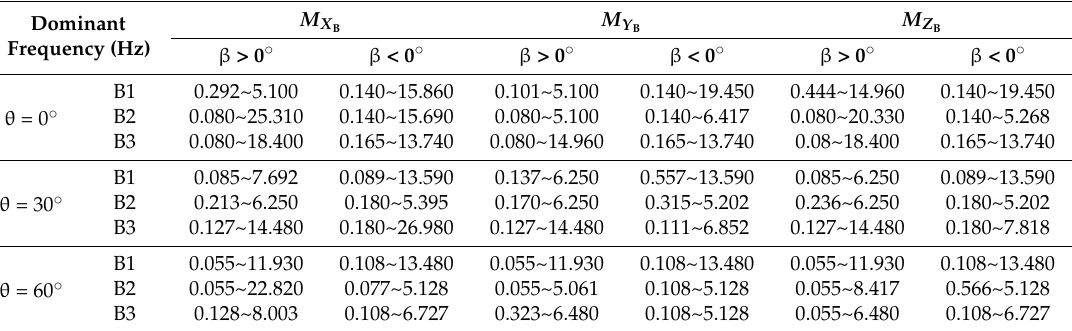
Table 4. Range of the dominant frequency of the blade root bending